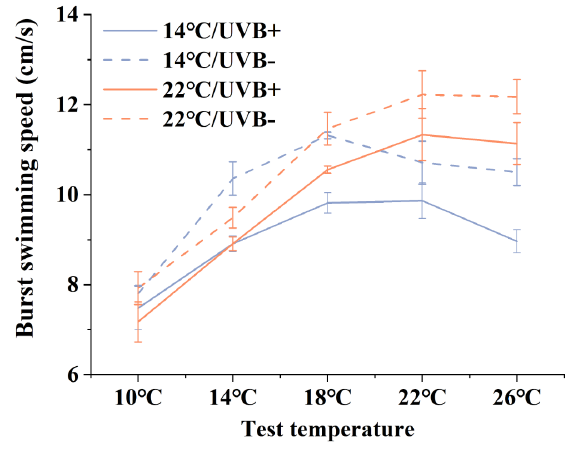
Figure 2. Effect of UVBR (solid lines) and UVBR–free (dashed lines) environments in combination with either a 14 (blue lines) or 22 °C (red lines) temperature on the burst swimming speed in Rana kukunoris tadpoles. Lines show the trend in the burst swimming speed for each group at five tem- peratures (10, 14, 18, 22, and 26 °C), respectively. In addition, the UVBR treatment reduced the burst swimming speed of the tadpoles (Figure 2). In the 14 °C groups, the burst swimming speed of the tadpoles in the UVBR group was lower than that in the UVBR-free group at 14, 18, and 26 °C ( F 3,36 = 7.299, p < 0.01; F 3,39 = 10.184, p < 0.01; F 3,36 = 14.636, p < 0.01, respectively). In the 22 °C groups, the